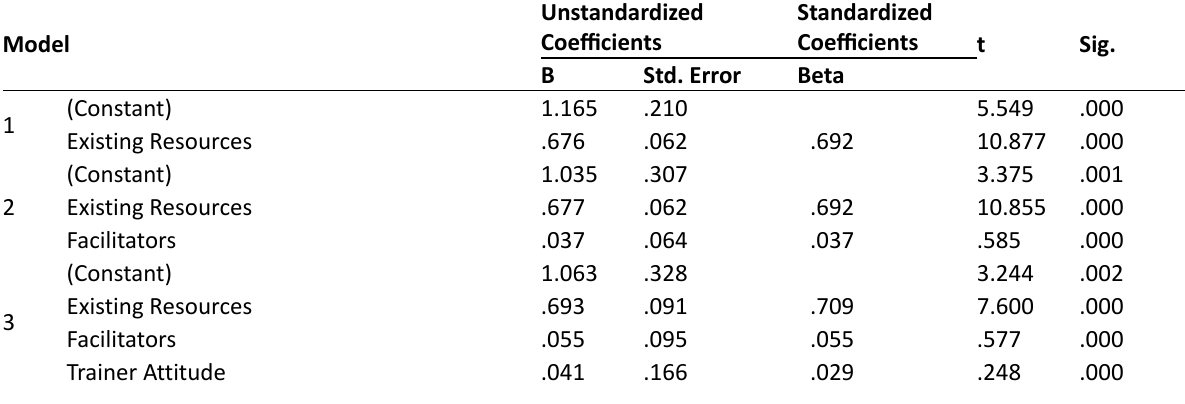
Table 3. Coefficients